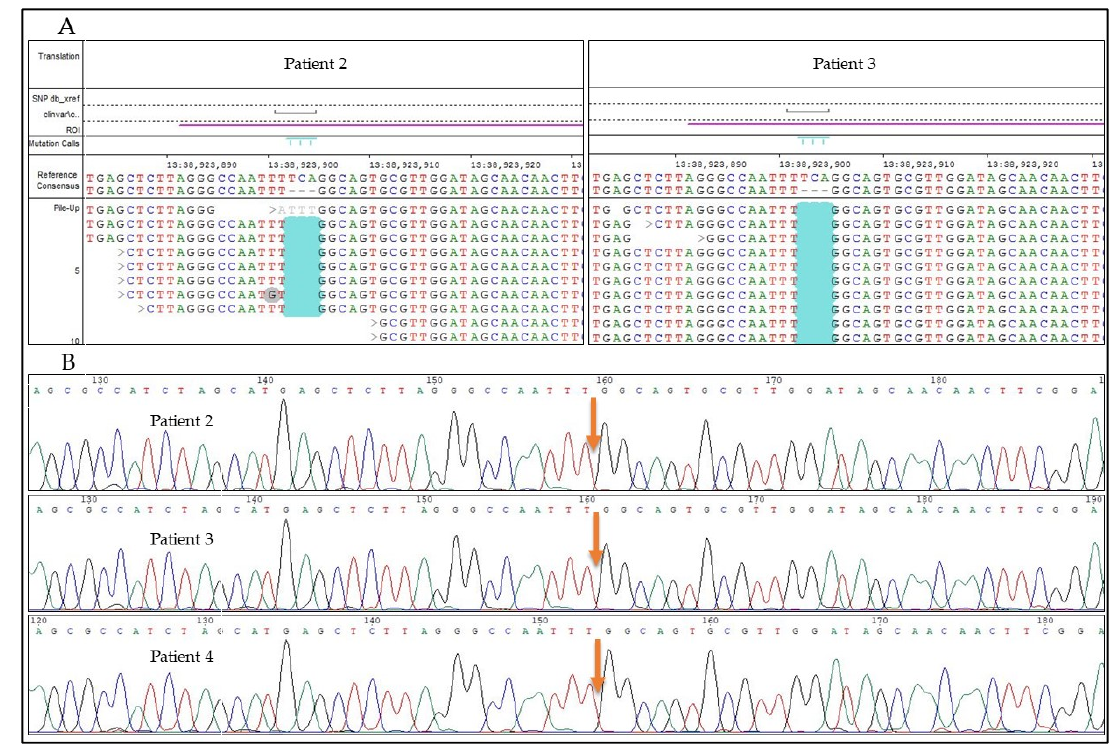
Figure 4. Next-generation sequencing ( A ) results of Patients 2 and 3. Sanger sequencing ( B ) results of Patients 2, 3, and 4. All three patients are homozygous for the UFM1 : c.-155_-153delTCA mutation.